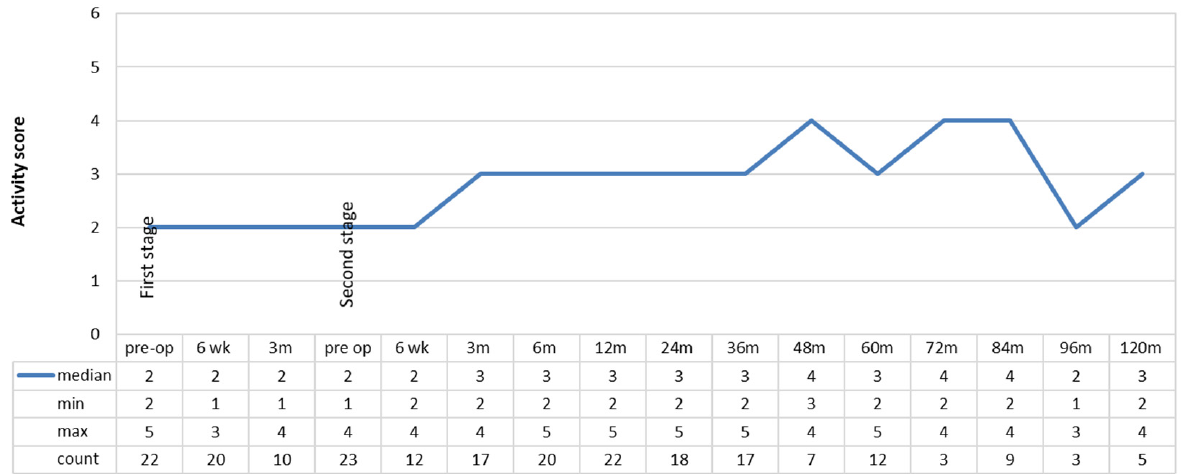
Figure 4. Activity level ratings using the SICOT activity score. SICOT activity: 1 = bedridden/wheelchair, 2 = sedentary, 3 = semi-sedentary, 4 = light labour, 5 = moderate manual labour, and 6 = heavy manual labour.